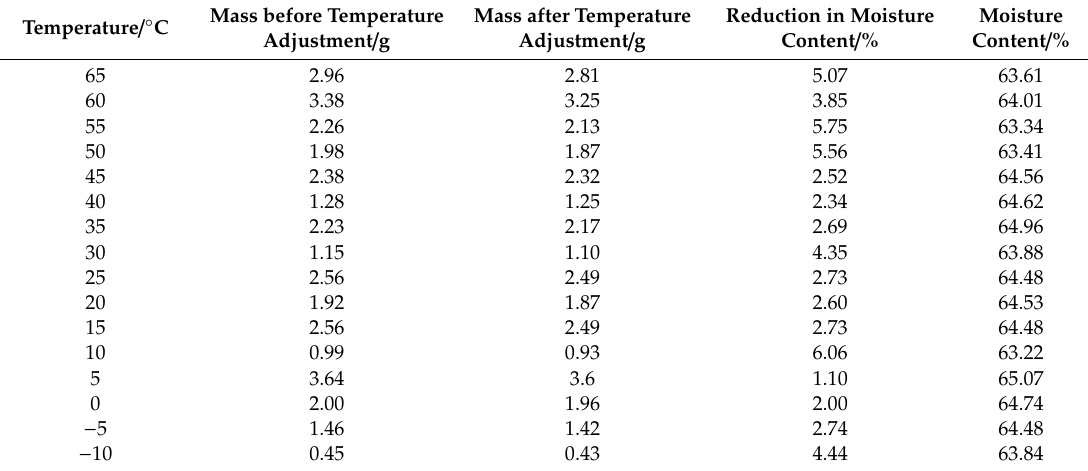
Table 10. E ff ect of incubator controlling rice leaves and grains on moisture